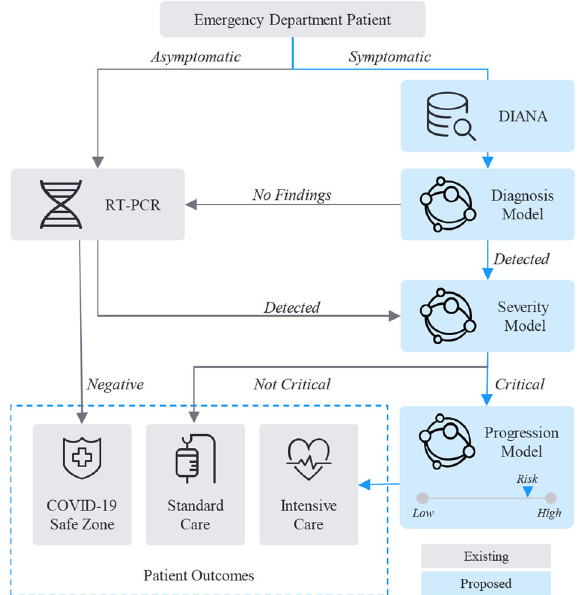
Fig. 3 COVID-19 triage pipeline. The blue arrows represent an illustrative example of how a patient presenting with severe COVID- 19 and high risk for critical deterioration would be triaged via the automated pipeline. Recommended patient outcomes would require physician approval before